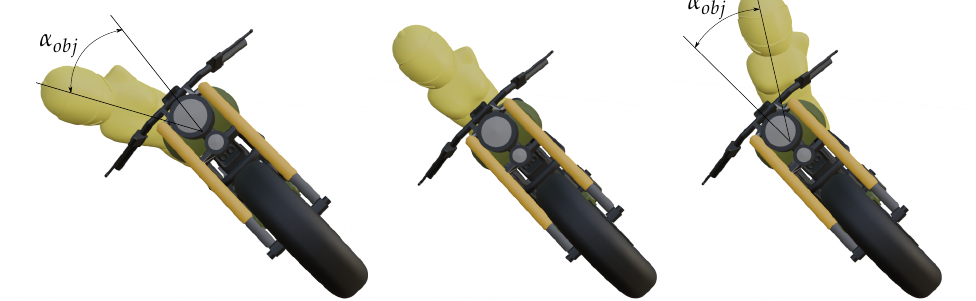
Figure 4. Inside, neutral, and outside configurations in a torso